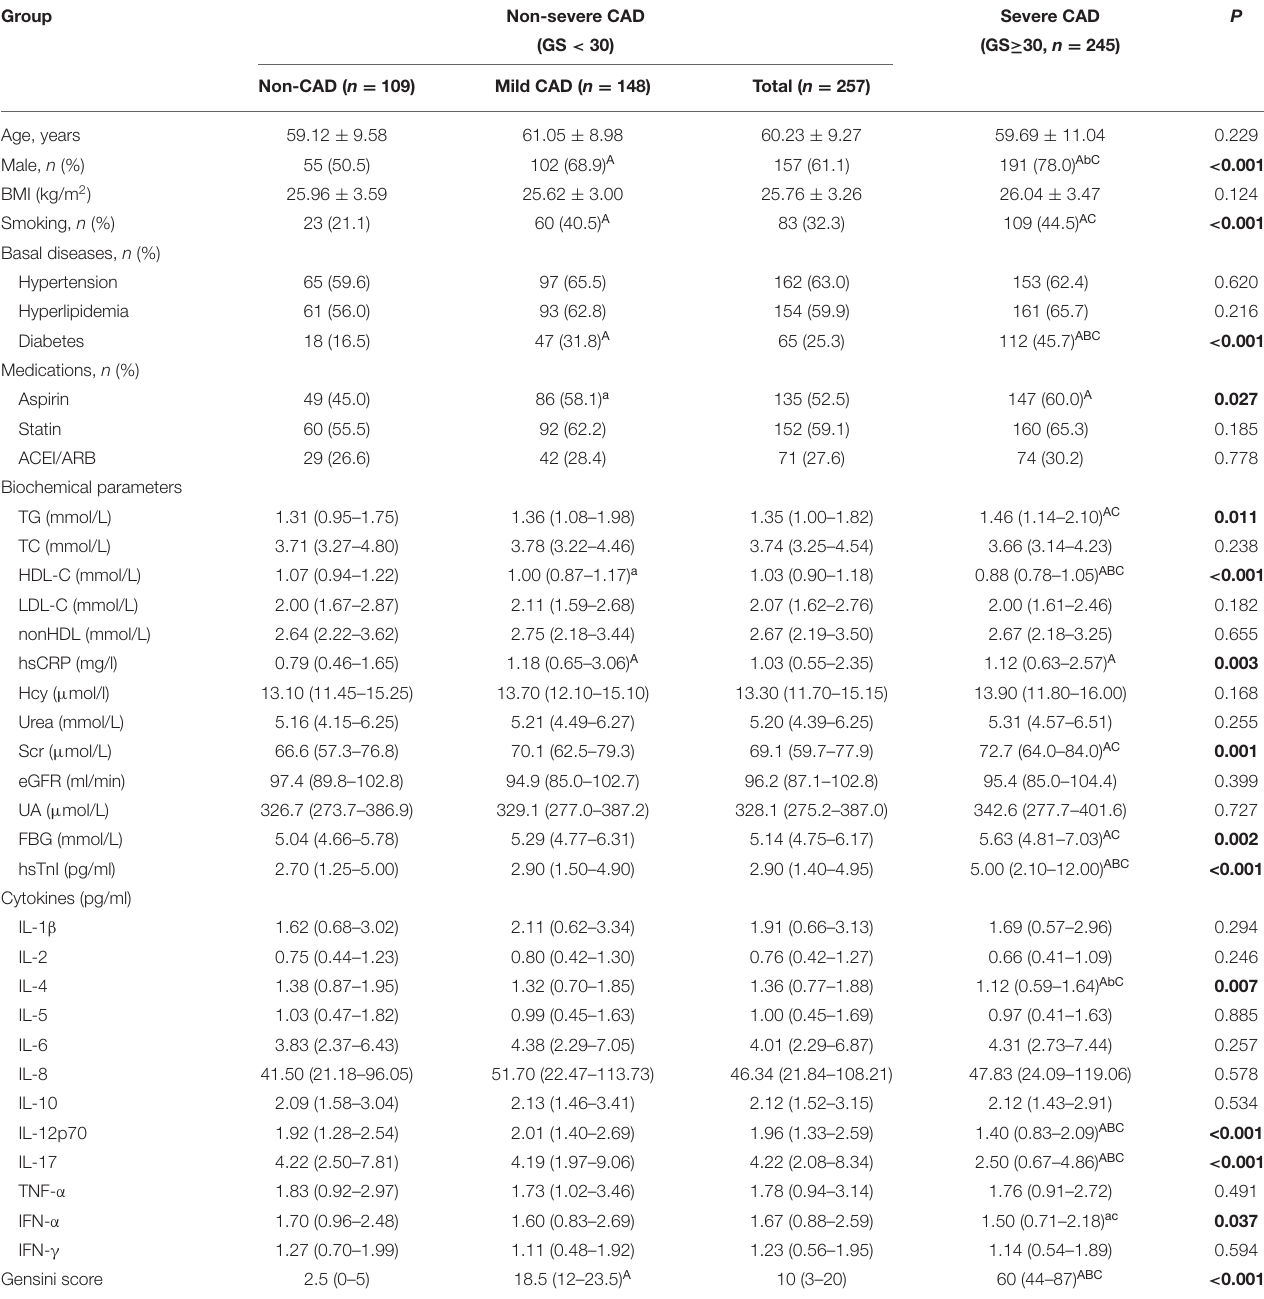
TABLE 1 | Clinical characteristics and serum cytokine levels of patients in each group. Group Non-severe CAD Severe